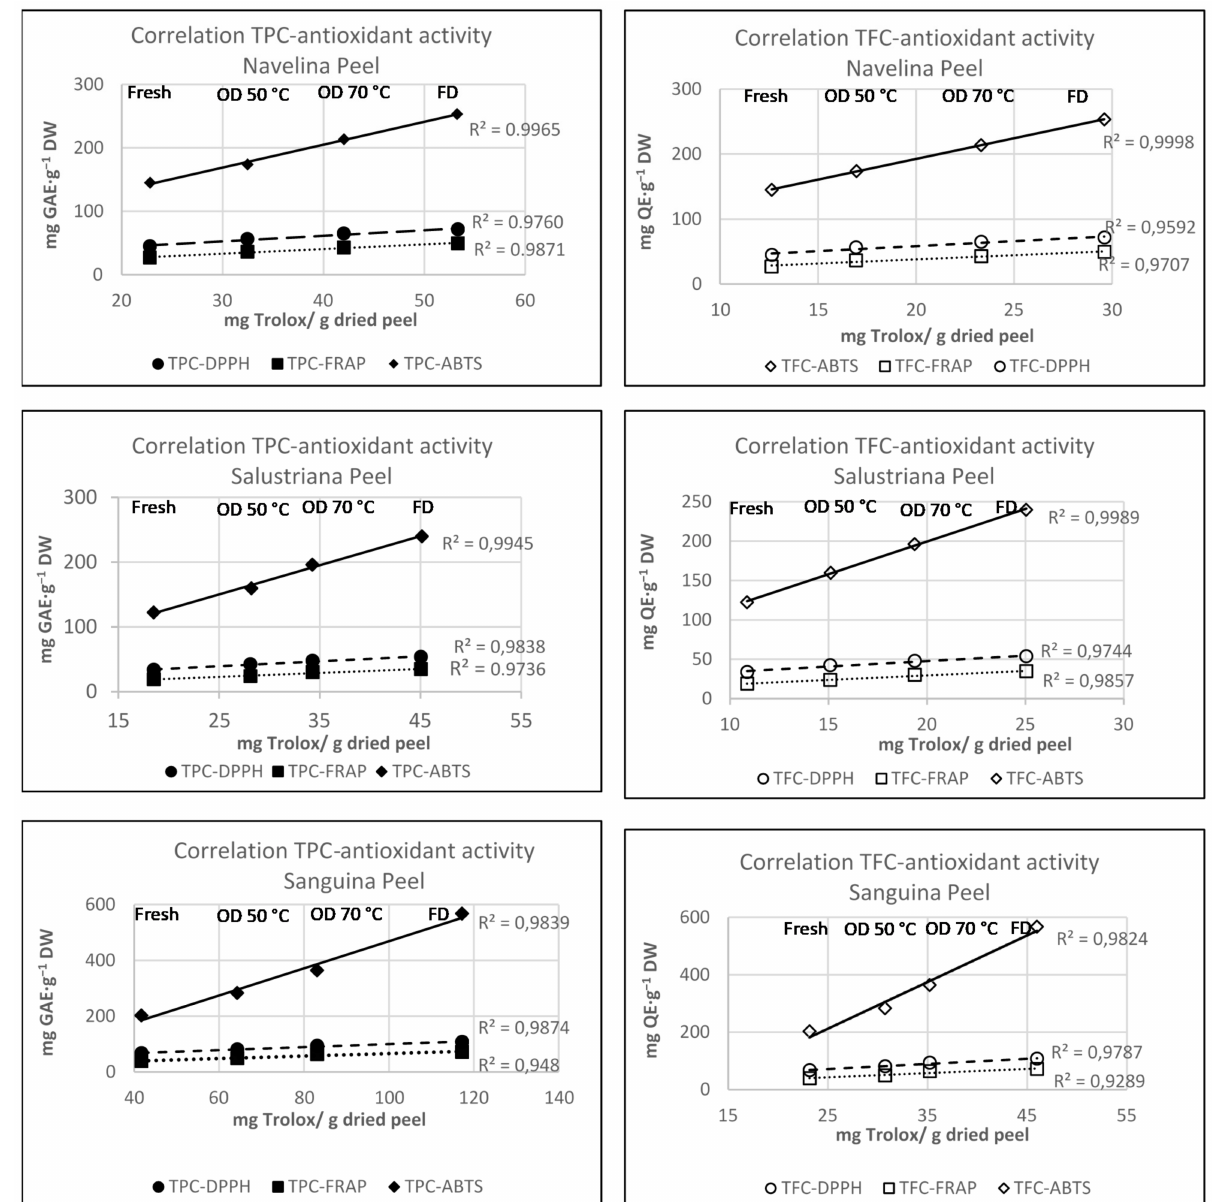
Figure 5. Correlation between total phenols content, total flavonoids content, and DPPH, FRAP and ABTS assay, of fresh, oven-dried, and freeze-dried orange peels from Navelina, Salustriana, and Sanguina varieties. OD—oven-dried; FD—freeze-dried; DW—dry weight; TPC—total polyphenol content (expressed as mg gallic acid equivalent AE · g − 1